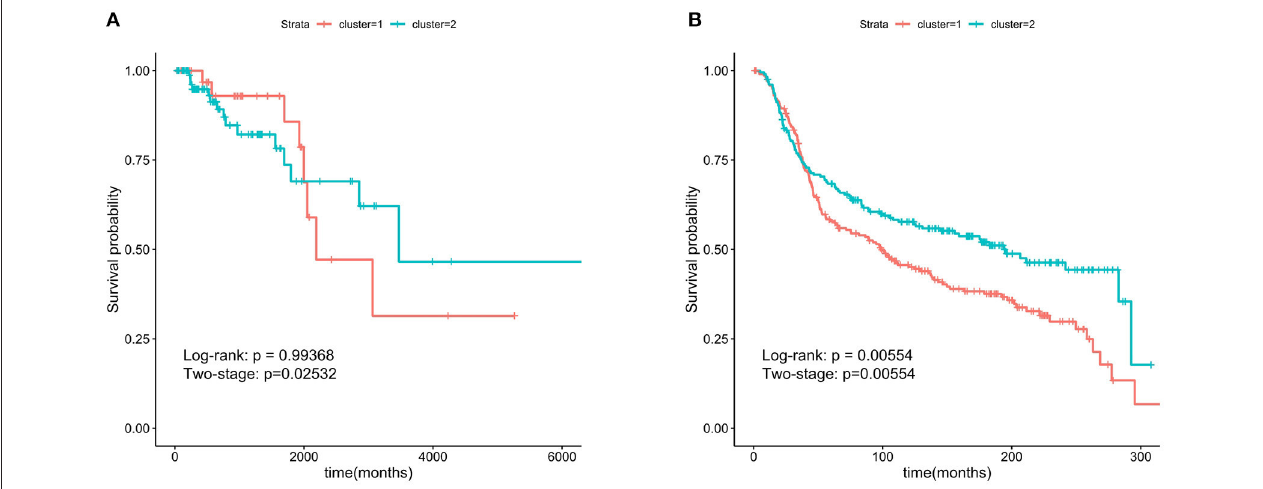
FIGURE 5 | Kaplan-Meier survival curves using the six hub SMGs. A few hub SMGs can represent the 227 important-SMGs and were able to separate the patients into two groups more significantly. (A) Six hub SMGs in TCGA. (B) Six hub SMGs in